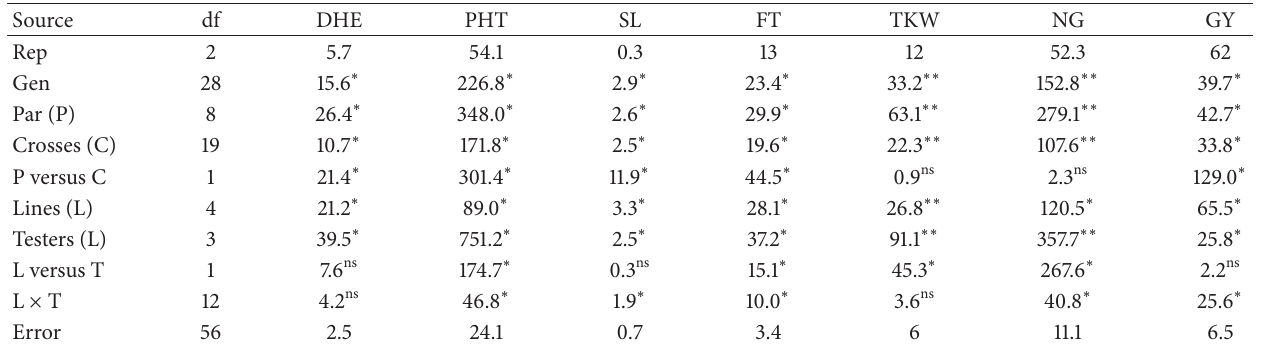
Table 2: Analysis of variance for combining ability effects of different bread wheat